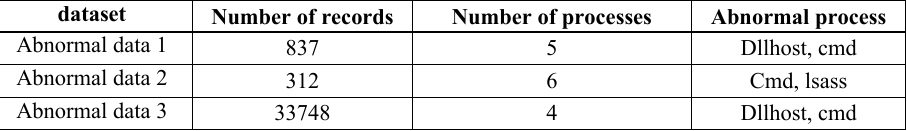
Table 2. Abnormal data 1